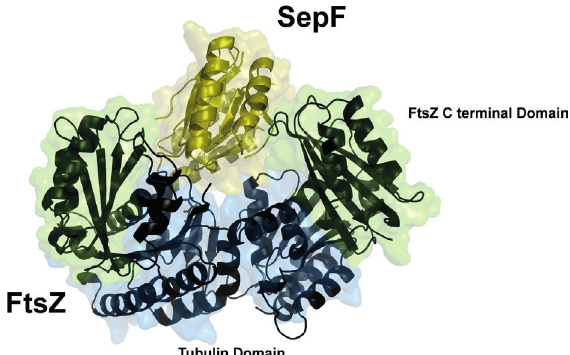
Figure 4 - Scheme that represents the interaction of SepF protein with the domains of FtsZ. Tubulin domain represented by blue color and C-terminal domain represented by green color.